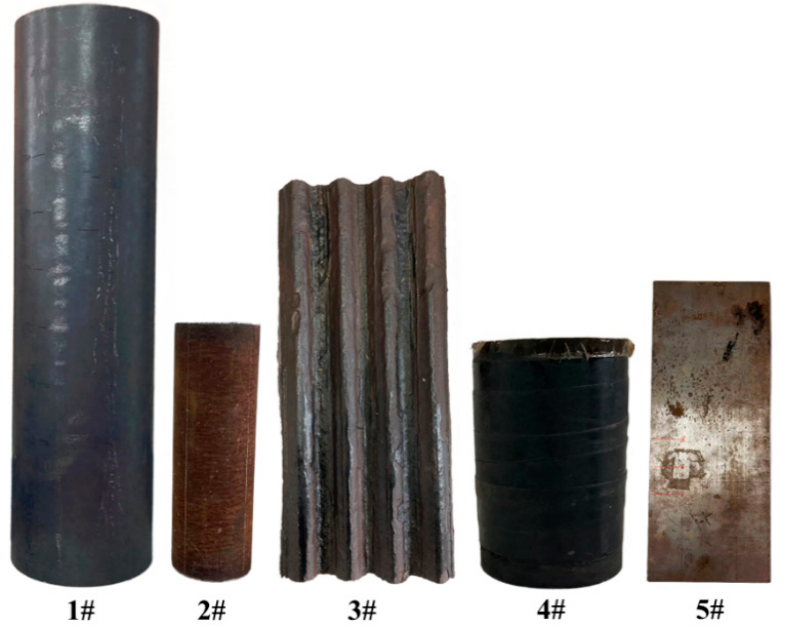
Figure 3. Schematic diagram of EMAT testing system.